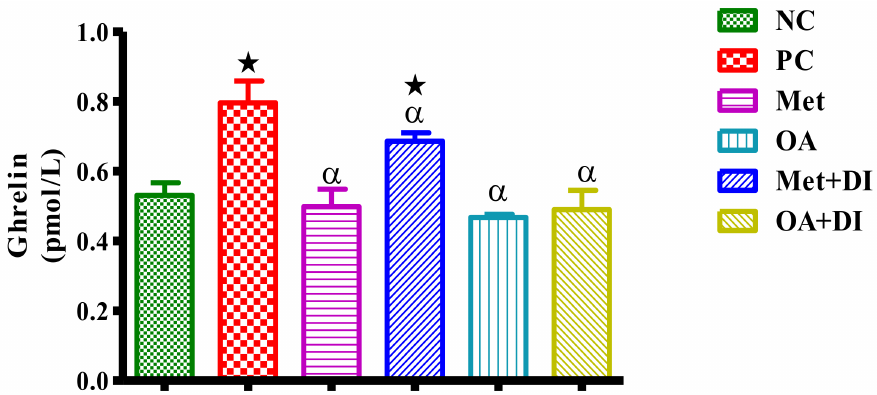
Figure 4. Effects of OA on plasma ghrelin concentrations of rats that continued with HFHC diet and those that changed diet or had diet intervention during treatment period. Values are presented as standard error of mean ± SEM. (cid:70) = p < 0.05 denotes comparison with NC; α = p < 0.05 denotes comparison with PC.